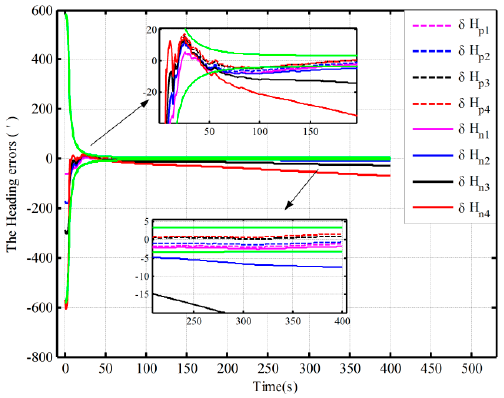
Figure 10. The alignment experiments based on the open-loop KF.